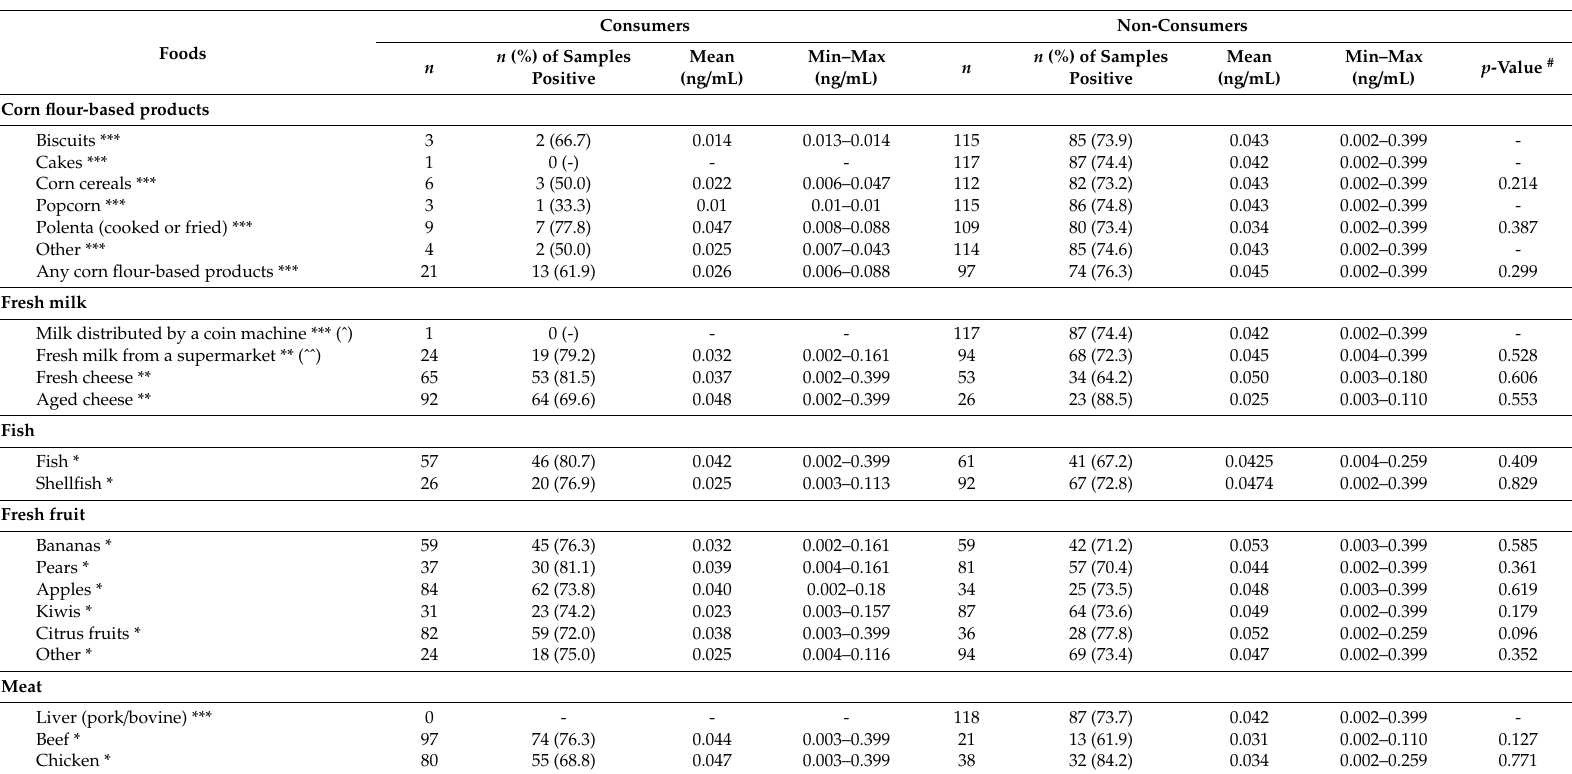
Table 1. Number of urine samples positive for aflatoxin FM1 (AFM1), means, ranges, p -values for AFM1 urinary levels in consumers of each kind of food compared to